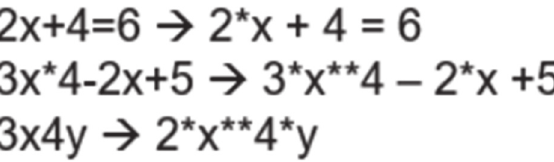
Figure 18: An example of text processing before using the SymPy module.